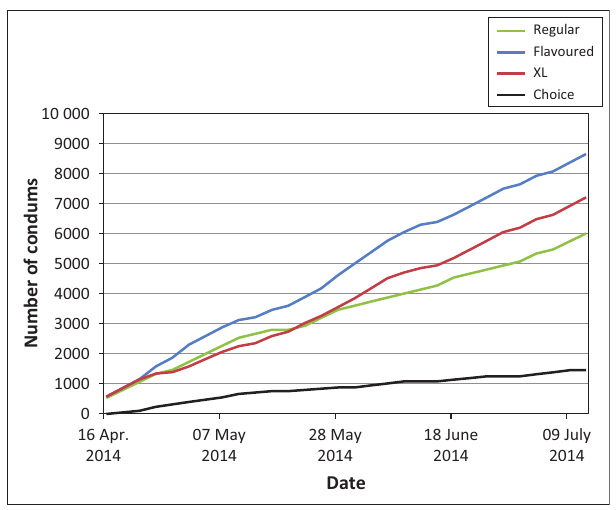
FIGURE 2: Cumulative total of condoms taken in Site C Youth Clinic: moving